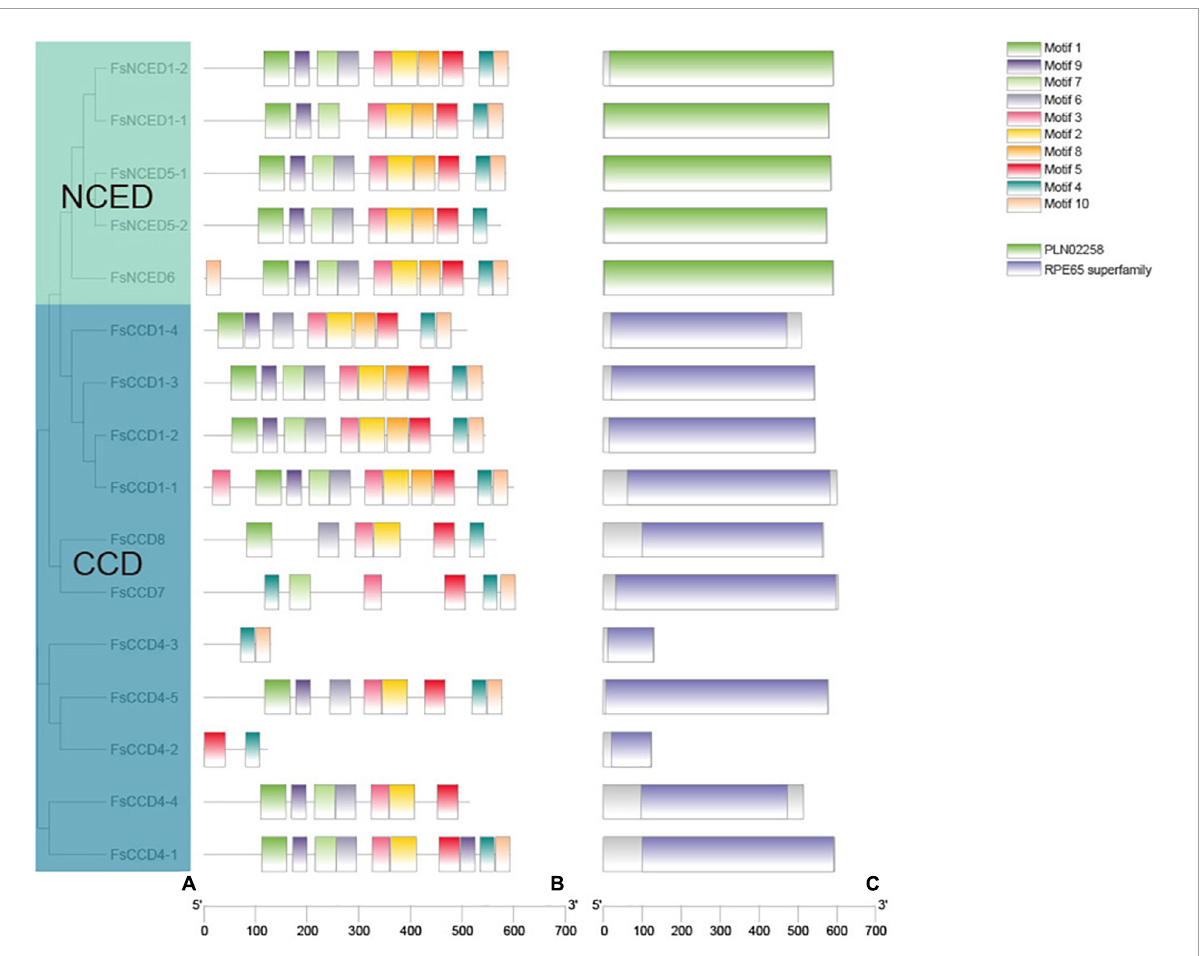
FIGURE4 The protein motifs and protein domain analysis of CCD genes of Forsythia suspensa . (A) Phylogenetic tree of CCD genes; (B) protein motif of CCD genes; (C) protein domain of WRKY genes.